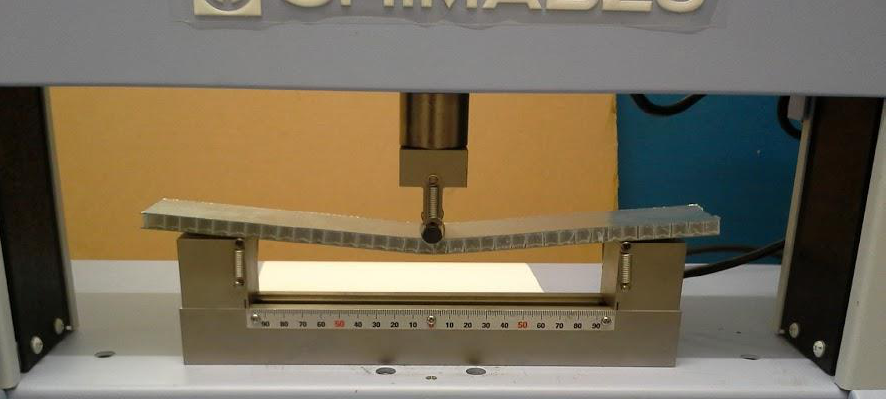
Figure 6. Bending test of sample c1.